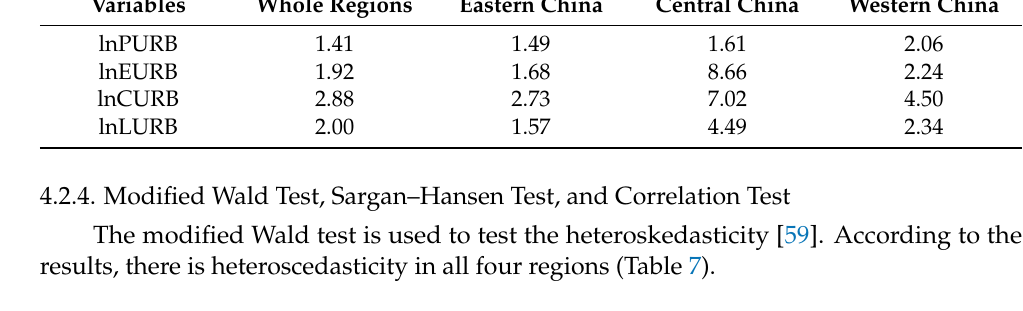
Table 7. Heteroscedasticity tests’ results.